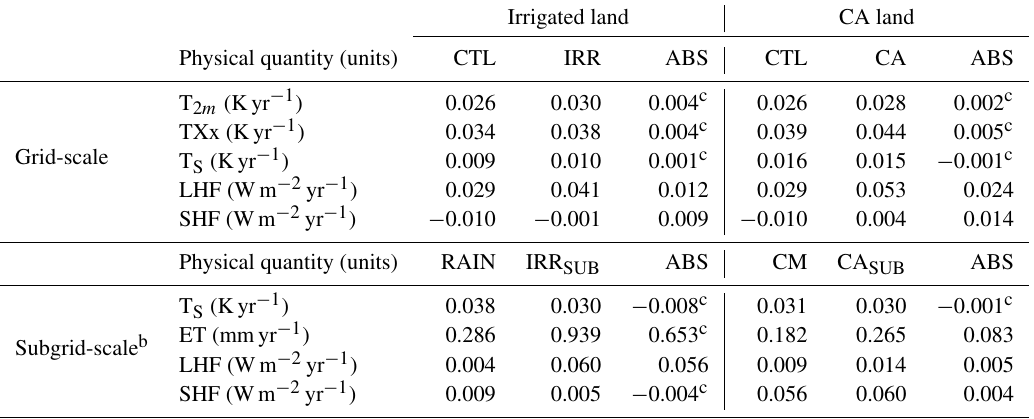
Table 3. Impact of irrigation and CA on various climatological values (absolute slope differences calculated as IRR minus CTL and CA minus CTL for grid-scale, IRR SUB minus RAIN and CA SUB minus CM for subgrid-scale) for the years 1981–2010.